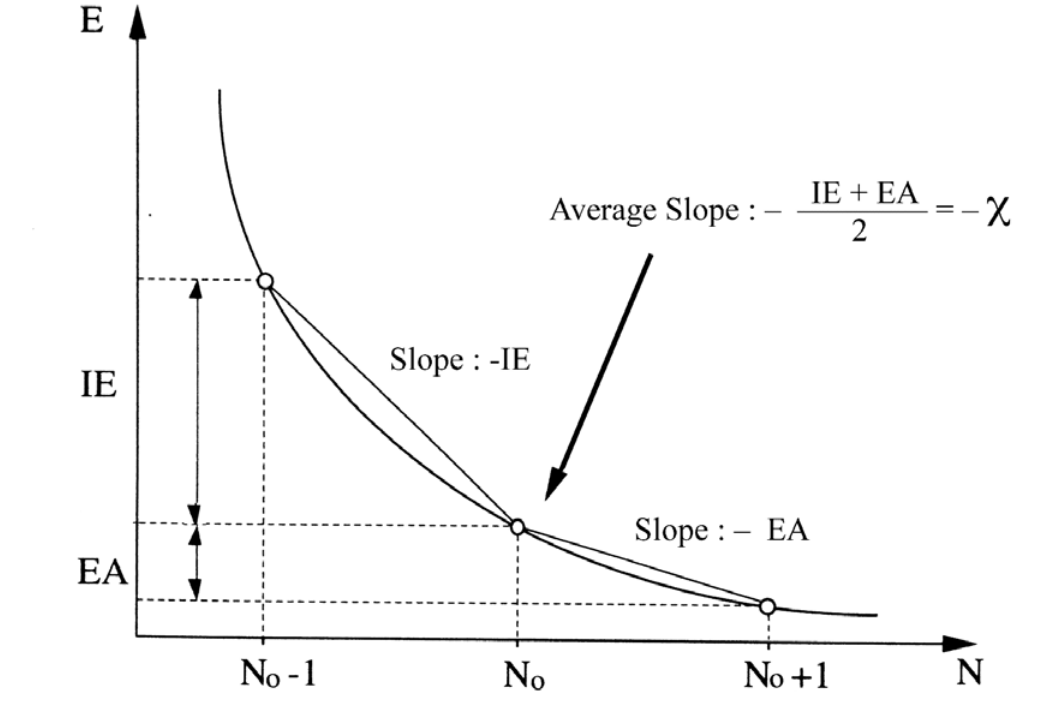
Figure 4 : Atomic or molecular energy (E) versus number of electrons (N) at constant external potential : the modern definition of